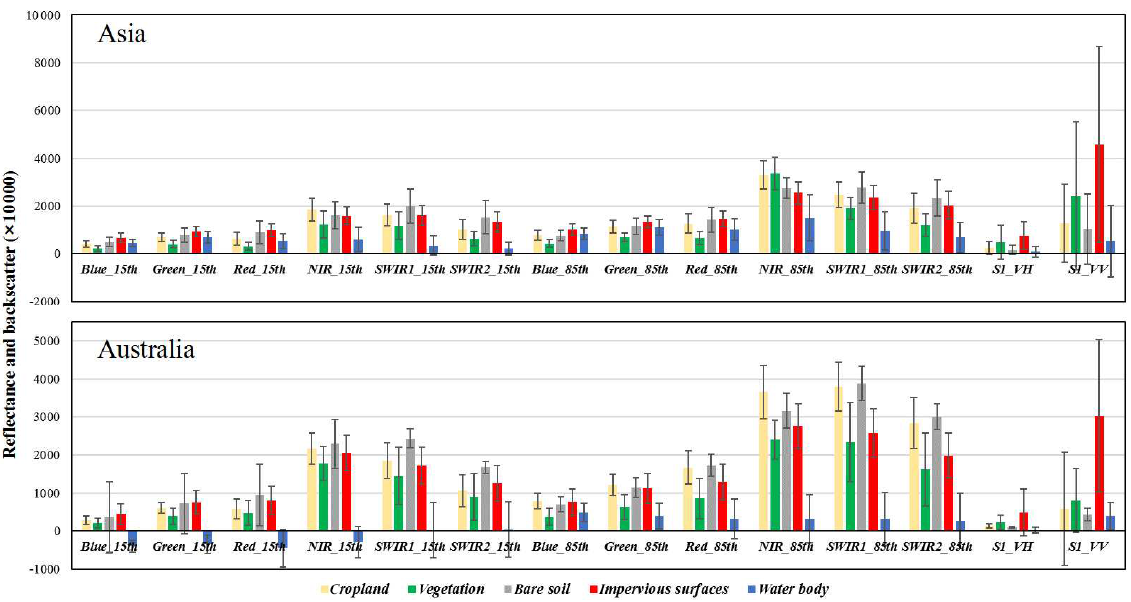
Figure 4. The reflectance and backscatter characteristics of different land-cover types over Landsat optical and Sentinel-1 SAR imagery in the Asia and Australia